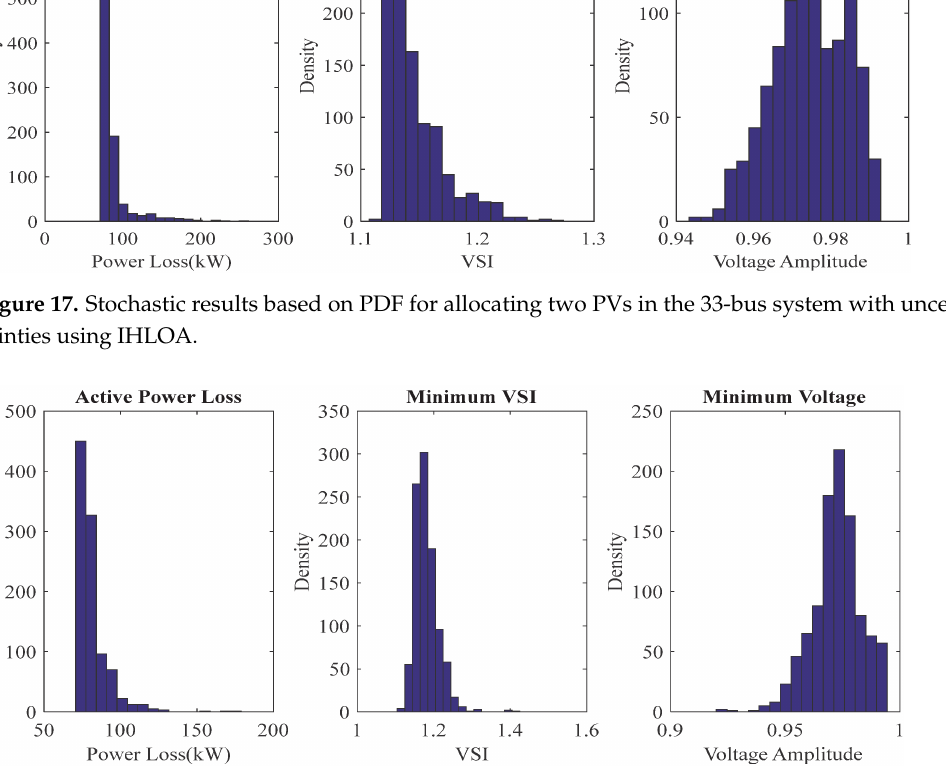
Figure 18. Stochastic results based on PDF for allocating two PVs in the 69-bus system with uncer- tainties using IHLOA.